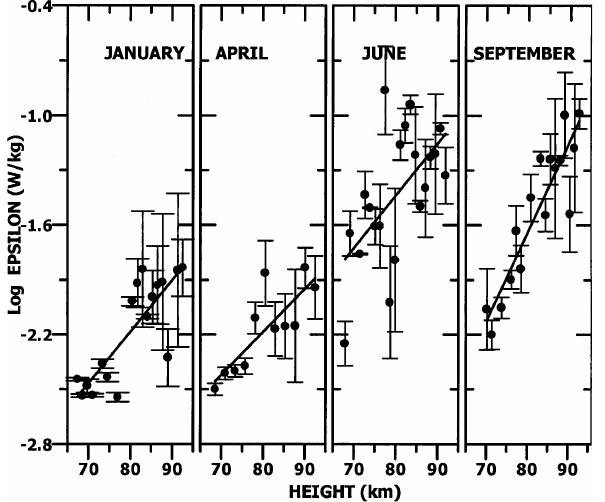
Fig. 2. Same as Fig. 1, but for vertical eddy diffusion coefficient (K z